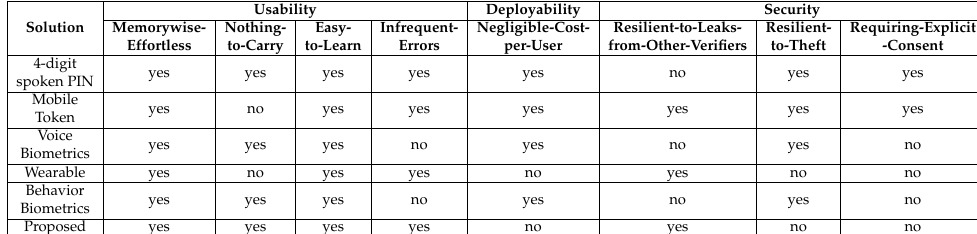
Table 4. Comparison of proposed solution with related work considering third-party metrics.